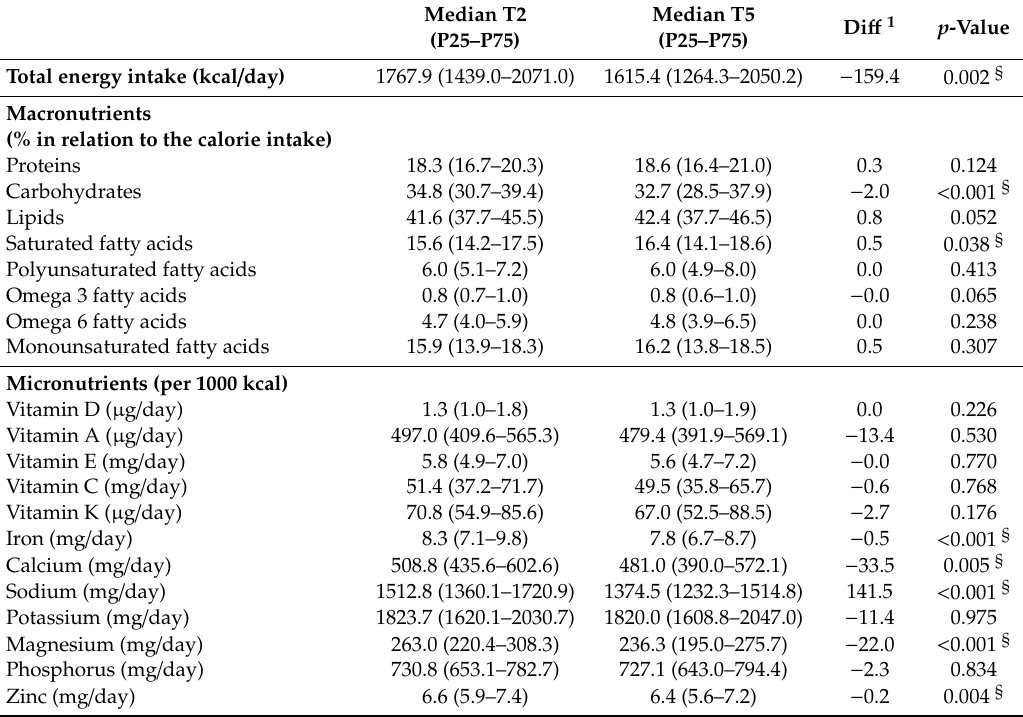
Table 2. Dietary characteristics of participants at T2 and at T5 and mean change over a 3-year follow-up (studied sample n =